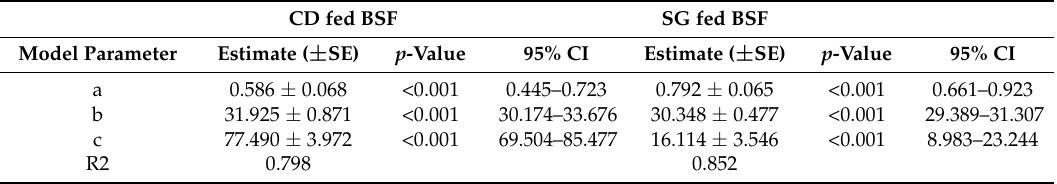
Figure 1. Temperature-driven model (parametrized square function) of ( a ) larval and ( b ) pupal developmental time (in days) of black soldier fly reared on two different organic substrates at five different temperature regimes. Table 6. Estimates of linear model parameters describing the relationship between temperature and developmental time of black soldier fly larvae reared on two different organic